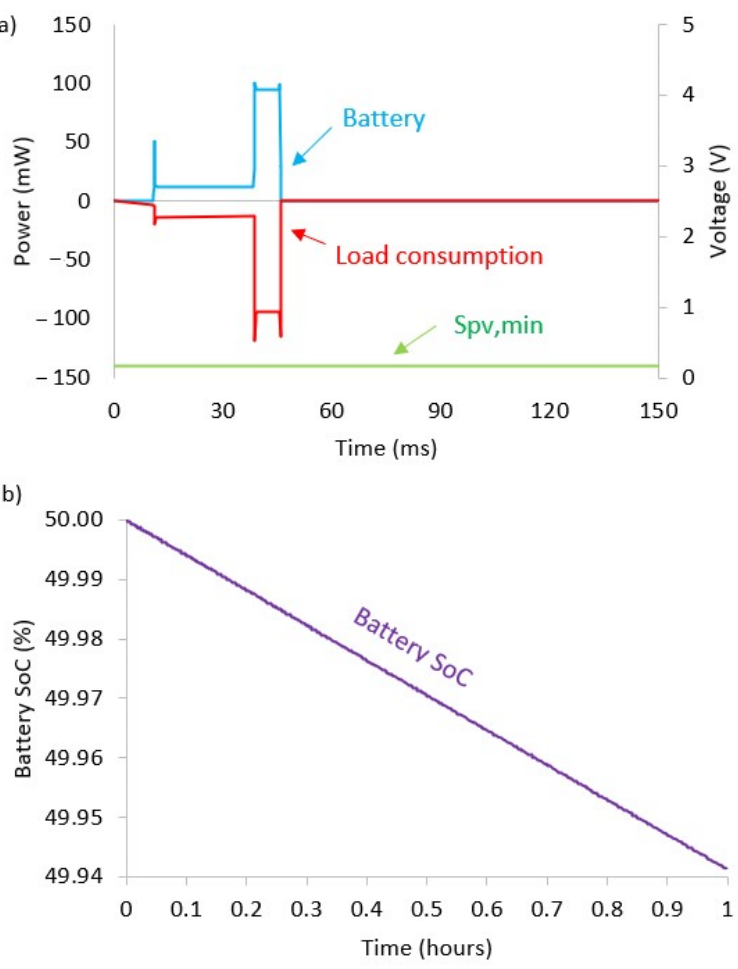
Figure 8. The charger simulation during no power generation: ( a ) the charger behavior and ( b ) battery discharge for one hour.